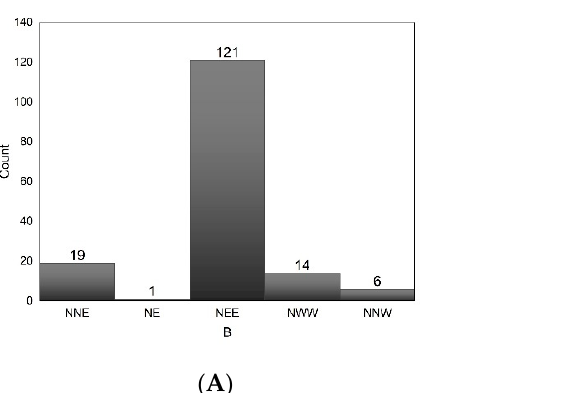
Figure 7. Interpreted map of remote sensing geological background information map (the base im- age is a combination of the 432 Sentinel-2 bands).